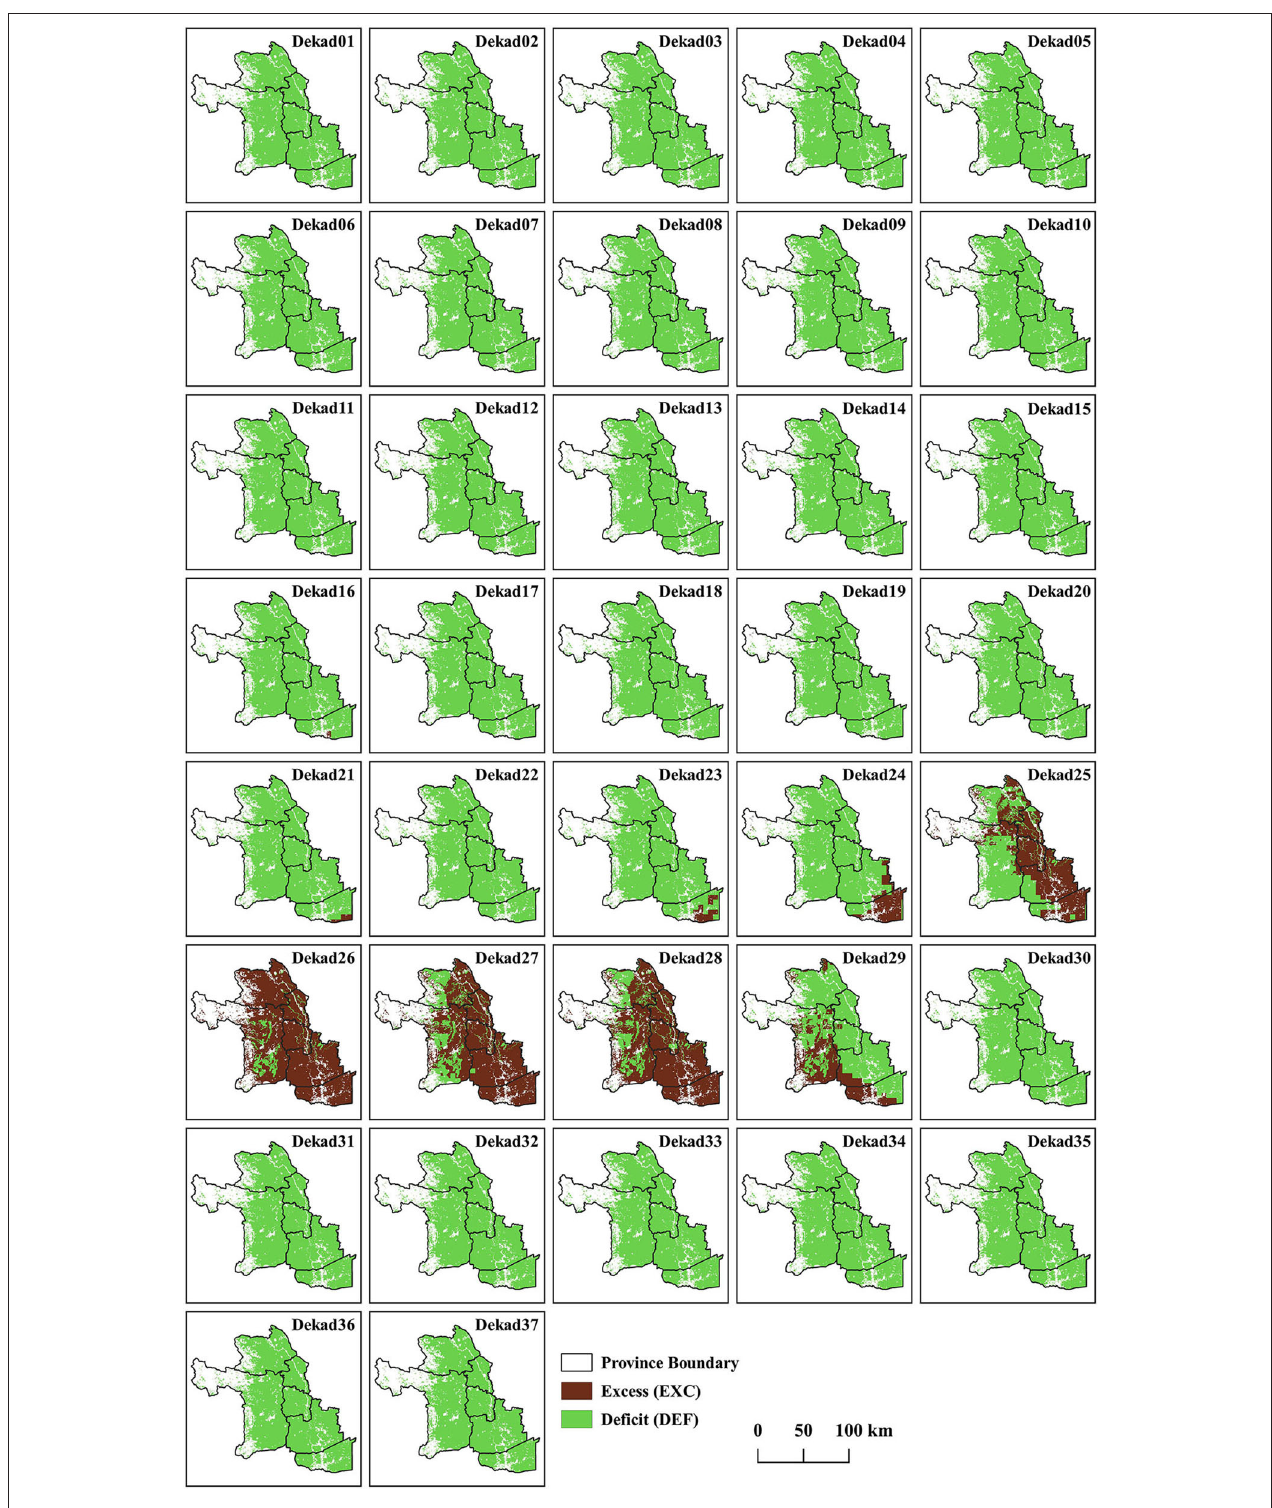
FIGURE 6 | Dekadal scoring maps for water